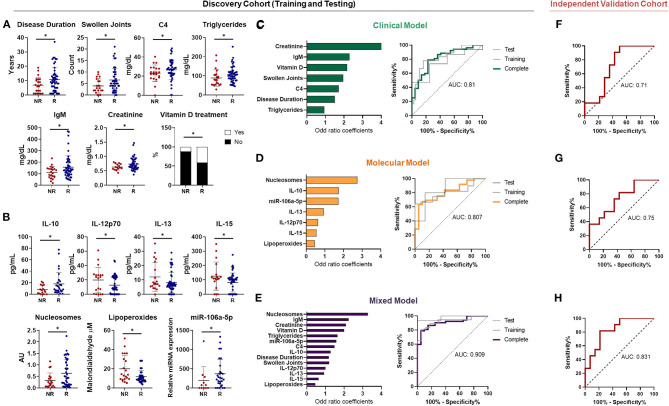
Biomarkers predictors of anti-TNF response in rheumatoid arthritis by using machine learning. (A) Baseline clinical variables associated with the EULAR clinical response to Anti-TNF in Rheumatoid Arthritis (RA) patients after 6 months (n = 74, including 52 R and 22 NR). (B) Baseline molecular variables associated with the EULAR clinical response in RA patients after 6 months. (C) ROC curve of the machine learning model predictor of clinical response (left panel) using only clinical variables and their individual contribution represented by the odd ratio coefficients (right panel). (D) ROC curve of the machine learning model predictor of clinical response (left panel) using only molecular variables and their individual contribution represented by the odd ratio coefficients (right panel). (E) ROC curve of the machine learning model predictor of clinical response (left panel) using the best combination of clinical and molecular variables and their individual contribution represented by the odd ratio coefficients (right panel). (F) ROC curve of the machine learning model predictor of clinical response in an independent validation cohort. (G) ROC curve of the machine learning model predictor of molecular response in an independent validation cohort. (H) ROC curve of the machine learning model predictor using both clinical and molecular variables. (validation cohort: n = 25, including 14 R and 11 NR). *p < 0.05. R, responders; NR, non responders; AUC, area under the curve.